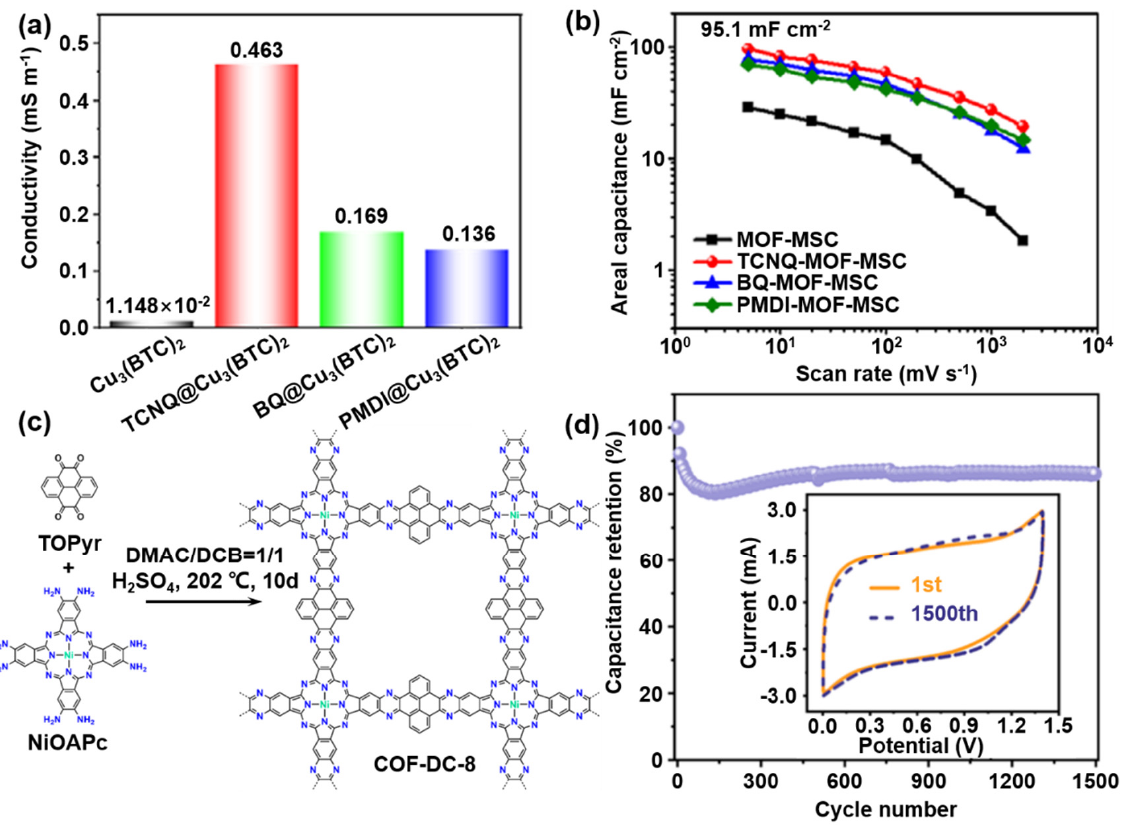
Figure 4. Surface conductivity modification on electrochemical performance. ( a ) Electrical conduc- tivities of the Cu 3 (BTC) 2 , TCNQ@Cu 3 (BTC) 2 , BQ@Cu 3 (BTC) 2 , and PMDI@Cu 3 (BTC) 2 thin films. ( b ) Specific capacitances calculated from CV curves as a function of scan rate [55]. Copyright 2020, Wiley-VCH. ( c ) Synthetic Route for 2D Conductive COF–DC–8 [57]. Copyright 2019, American Chemical Society. ( d ) Cycling stability test at 80 mV s − 1 . Inset: comparison of initial and 1500th CV curve [62]. Copyright 2021, American Chemical Society.